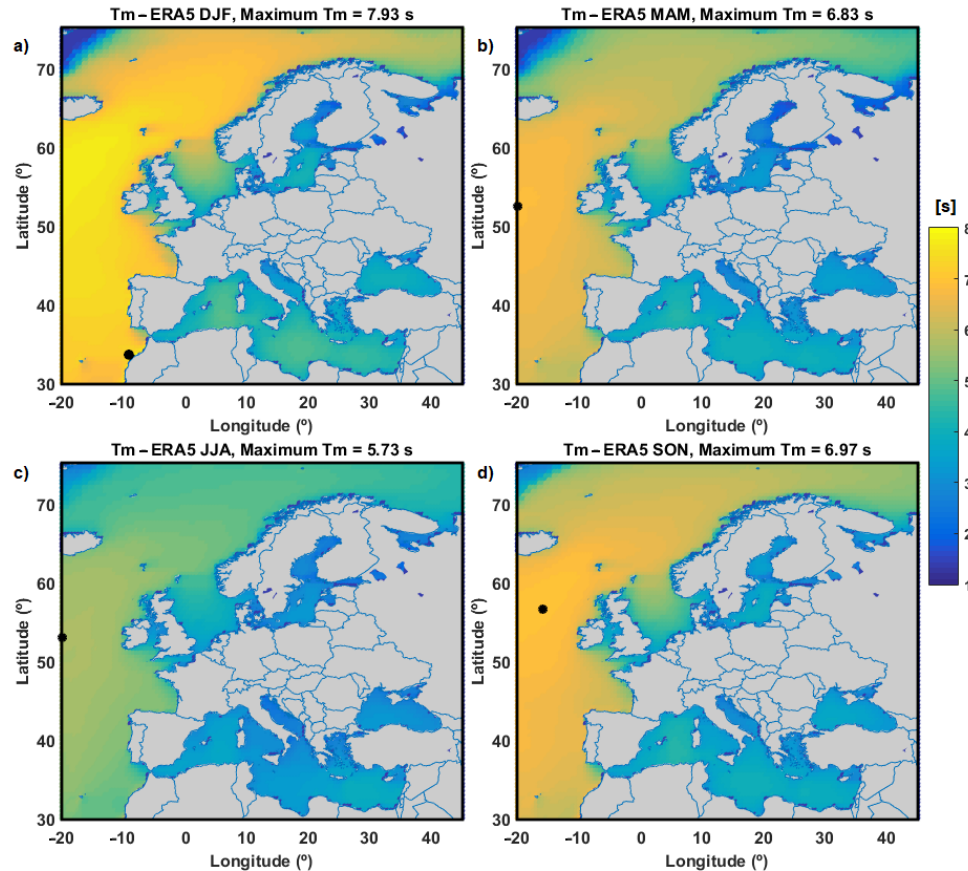
Figure 16. Seasonal variability of the mean wave period over the 20-year time interval (from 2001 to